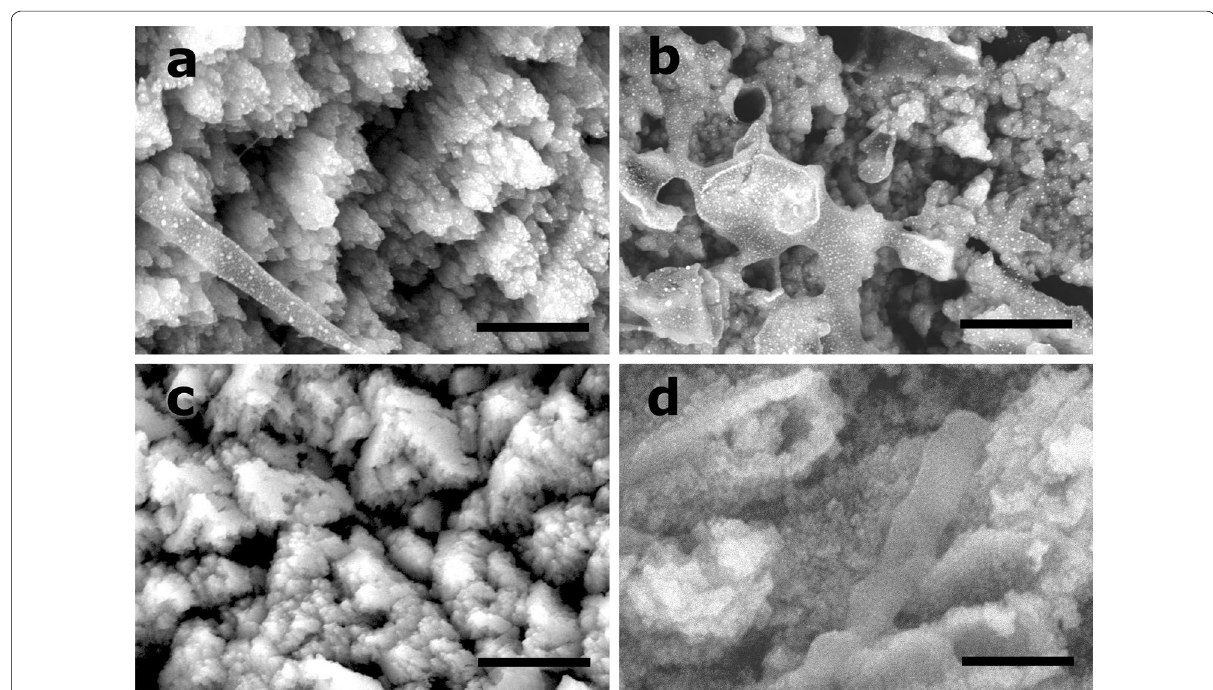
Fig. 4 BCC structures formed in non‑coupled and coupled calcium‑carbon sources. SEM images of BCC‑GLC ( a , c ) and BCC‑ACE ( c , d ) are shown. Scales ( a ) and rhombohedral calcite irregular shapes ( c ) are present. Crystallites grow over calcite aggregates and mineralized EPS in non‑coupled sources ( a , b ). Besides, induced mineralization occurs over the cell wall in coupled source ( d ). Scale bars: 1 μm.